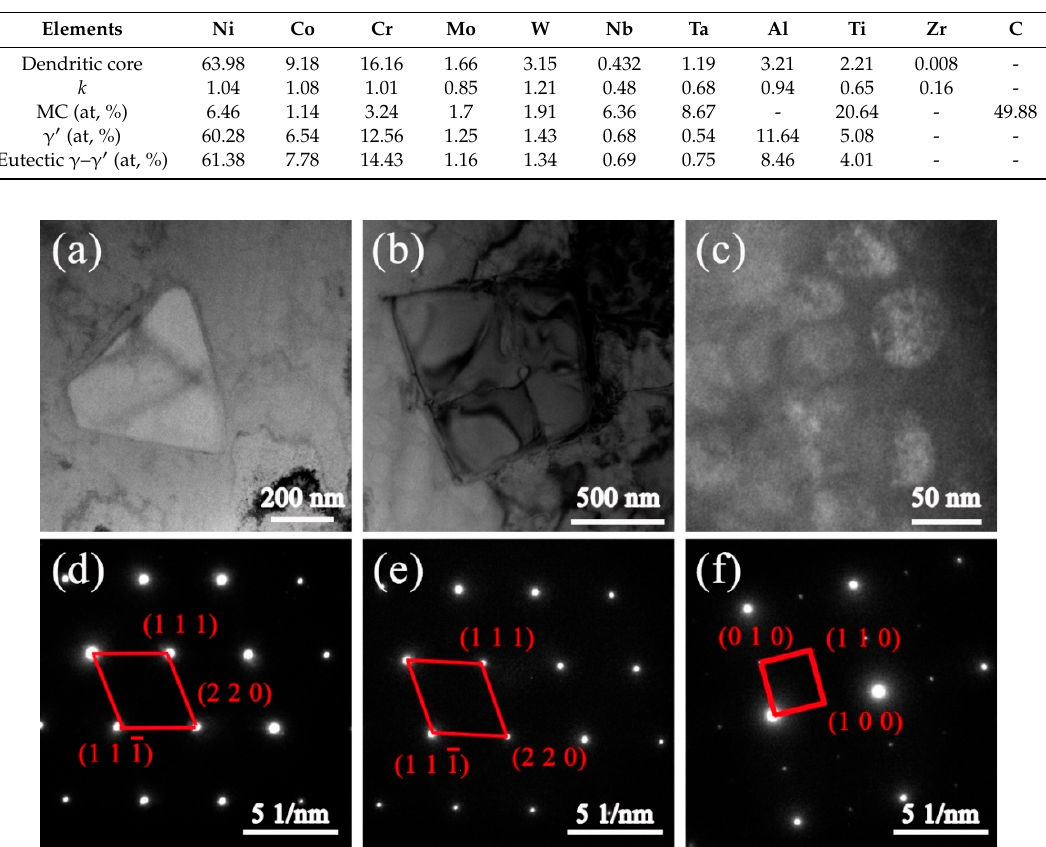
Figure 9. TEM micrograph of the ( a ) TiC, ( b ) (Nb,Ta)C, and ( c ) γ′ particles in the AF sample, and ( d – f ) corresponding selected area electron diffraction patterns (SADP), respectively.